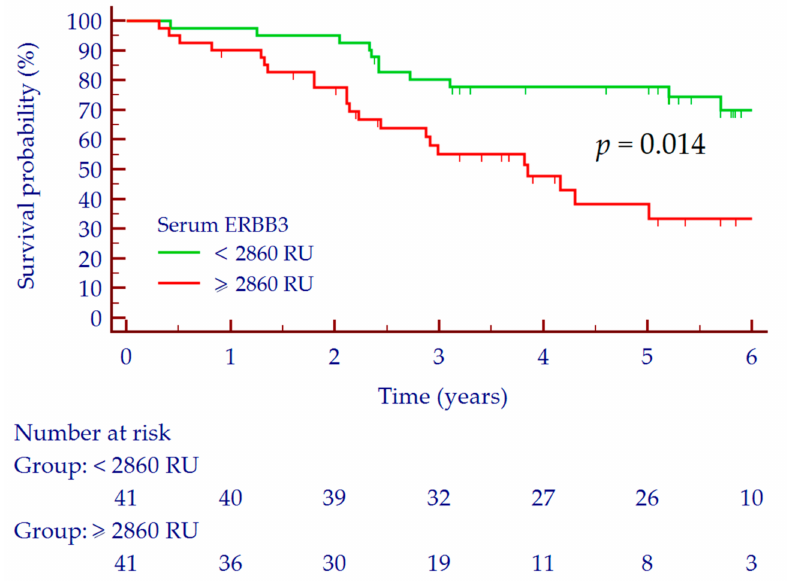
Figure 3. Survival curves according to serum ERBB3 ≥ 2860 RU. Small vertical lines indicate censored data. Abbreviations: epidermal growth factor receptor 3 (ERBB3), arbitrary REAAD™ Units (RU).